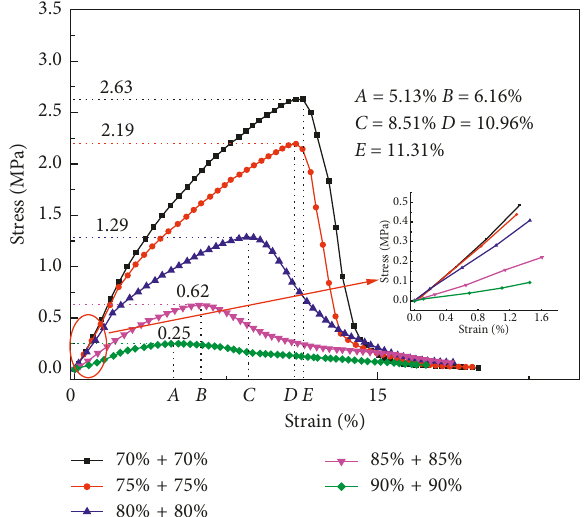
Figure 9: Uniaxial tensile stress-strain curves of soldered PCFSSs with the same